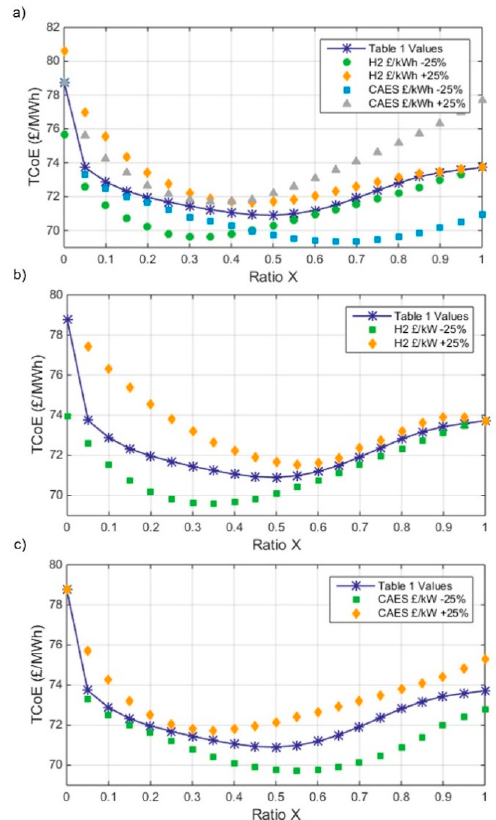
Figure 17. Sensitivity of 𝑇𝐶𝑜𝐸 to cost of technologies. ( a ) Variation of +/ − 25% in cost of storage capacity of both technologies. ( b ) Variation of +/ − 25% in H 2 cost of power conversion. ( c ) Variation of +/ − 25% in CAES cost of power conversion.